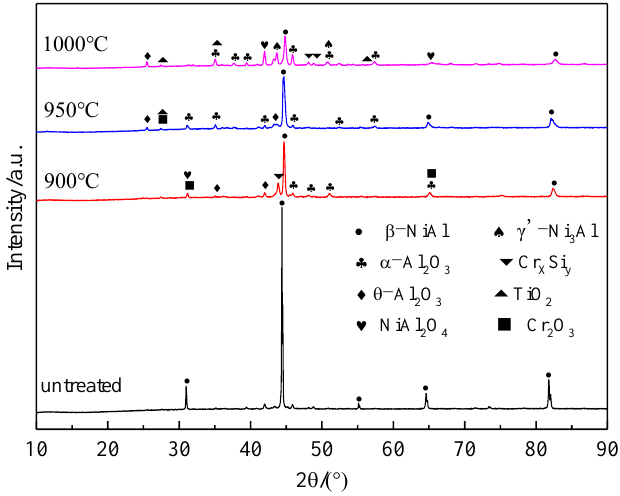
Figure 2. XRD patterns of Al-Si coatings pre-oxidized for 1 h at different pre-oxidation temperatures. According to Figure 3, there is a continuous oxide film mainly composed of α-Al 2 O 3 and θ-Al 2 O 3 on the surface of the pre-oxidized samples. The surface of PreO-900 °C is flatter, with an obvious black bulk area, which is mainly Al oxide and contains a small amount of Ti. The oxide films on the surface of PreO-950 °C and PreO-1000 °C are contin- uous and dense, which are composed of clusters of oxides, mainly α-Al 2 O 3 . At PreO- 1000 °C, some of the clustered oxides on the surface of the Al-Si coating are needle-like oxides, which can be identified as spinel Ni(Cr,Al) 2 O 4 based on shape analysis. This oxide has poor oxidation resistance and is easy to flake off. In the three groups of pre-oxidized samples, the oxide film on the surface of pre-oxidized samples at preo-950 °C is more continuous and dense, mainly α-Al 2 O 3 , and only a small amount of acicular oxides.